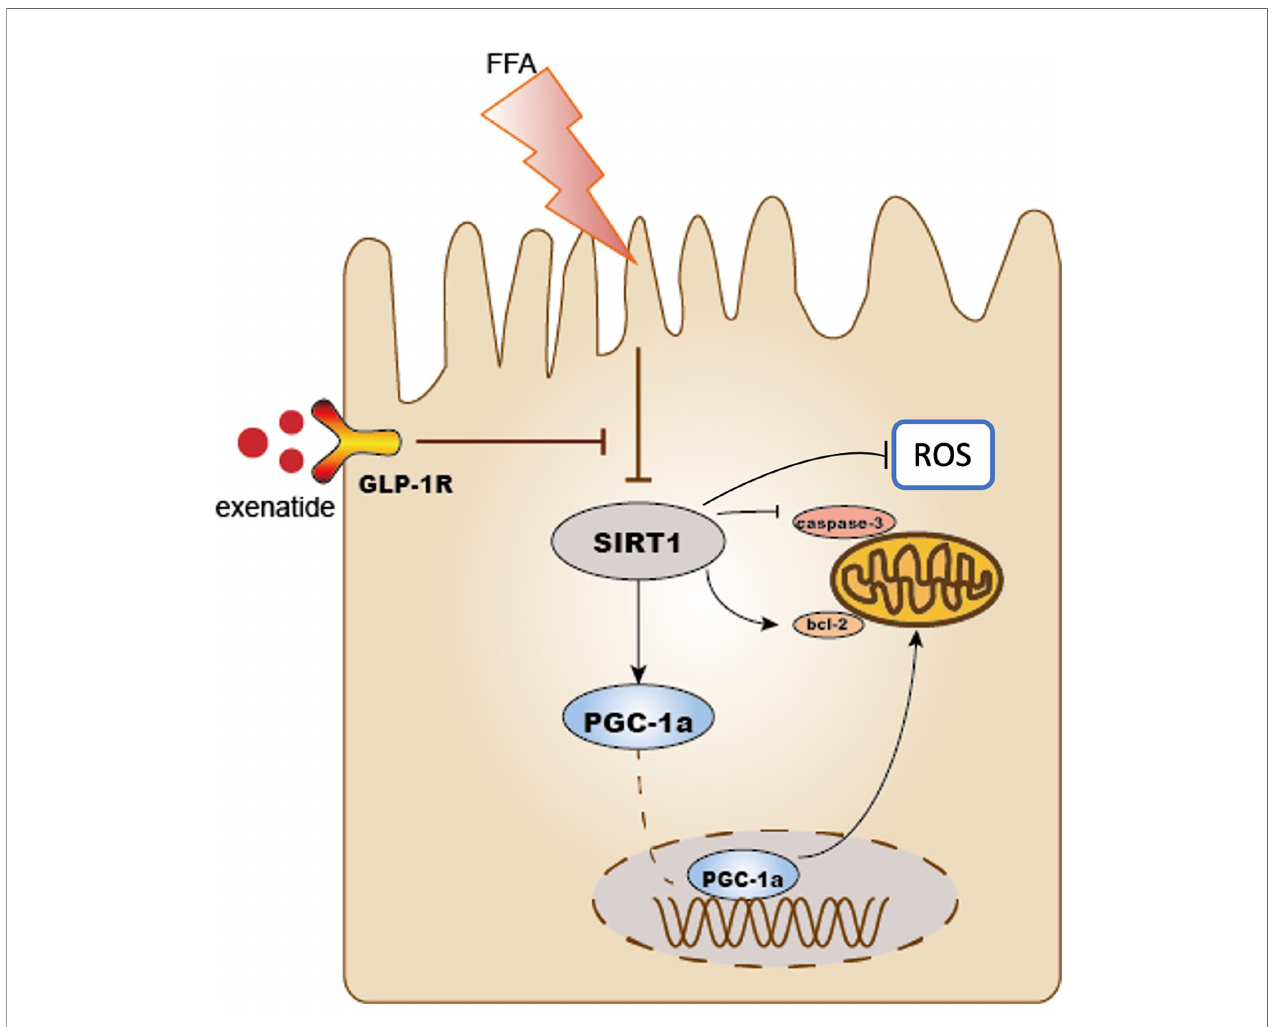
FIGURE 5 | Schematic diagram of this study. Exenatide protects HFD induced tubular injury through the preservation of SIRT1. SIRT1 positively regulates the expression of PGC-1 a . HFD reduced the expression of SIRT1 and PGC-1 a subsequently leads to mitochondria-derived ROS production and mitochondrial apoptosis, which results in the development of renal tubular injury. Treatment with exenatide increased the expression of SIRT1 and PGC-1 a and then prevented obesity-induced mitochondrial dysfunction. As a result, exenatide suppressed mitochondria-derived ROS production, alleviated mitochondrial dysfunction, reduced cell apoptosis, and protected against HFD-induced renal tubular